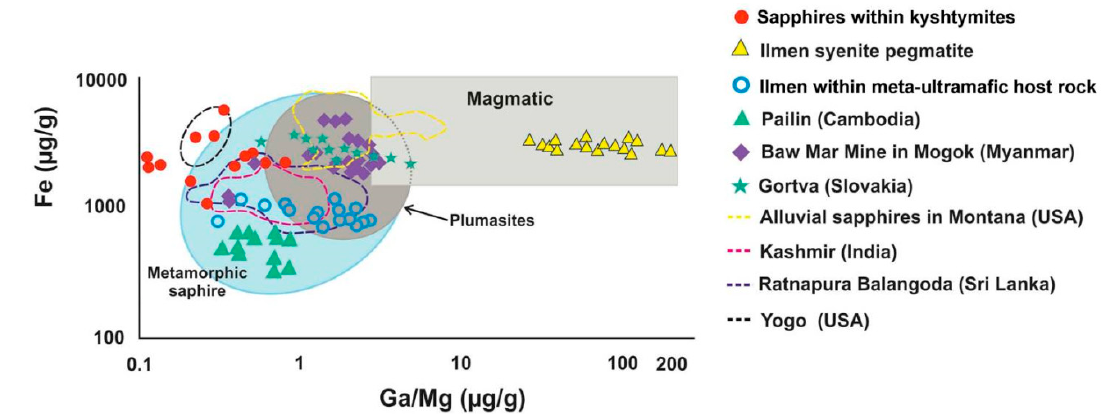
Figure 6. A Fe versus Ga / Mg diagram showing the boundaries for magmatic and metamorphic sapphires, modified after Peucat et al. (2007) [35] and Zwaan et al. (2015) [37] with blue sapphires within kyshtymites, Ilmen sapphires within syenite pegmatites [2], Ilmen sapphires within meta-ultramafic host rocks [3], and sapphire deposits from other regions after [35]: Ratnapura and Balangoda (Sri lanka), Kasmir (India), Yogo Gulch (USA), and Baw Mar Mine in Mogok. The plot of alluvial sapphires from Montana (USA) is after Zwaan et al. (2015) [37]; data on sapphires from the Hajacka, Gortva (Slovakia) are after Uher et al. (2012) [38]. On the Fe–Mg*100–Ti*10 ternary plot (Figure 7), the studied sapphires from kyshtymites also fall in the field of “metamorphic“ sapphires overlapping those within Ilmen meta-ultramafic host rocks (mine 418). Meanwhile, blue sapphires from anorthosites-kyshtymites overlap most of the other known metamorphic (Ratnapura in Sri-Lanka—purple dotted lines in Figure 7), metasomatic (Kashmir in India—pink dotted lines in Figure 7), magmatic (Mogok in Myanmar, Yogo in USA, and Gortva, Slovakia—filled symbols in Figure 7), and placer sapphire occurrences (Balangoda in Sri Lanka, Pailin in Cambodia, and Ilakaka in Madagascar, and Montana in USA).